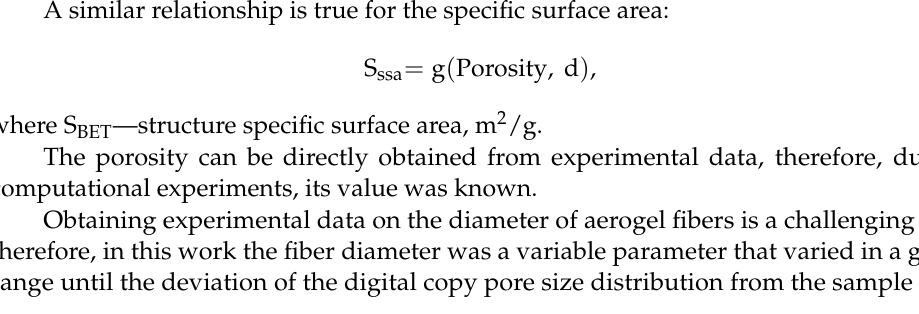
Figure 14. Sectional 3D digital structure of a chitosan-based aerogel.